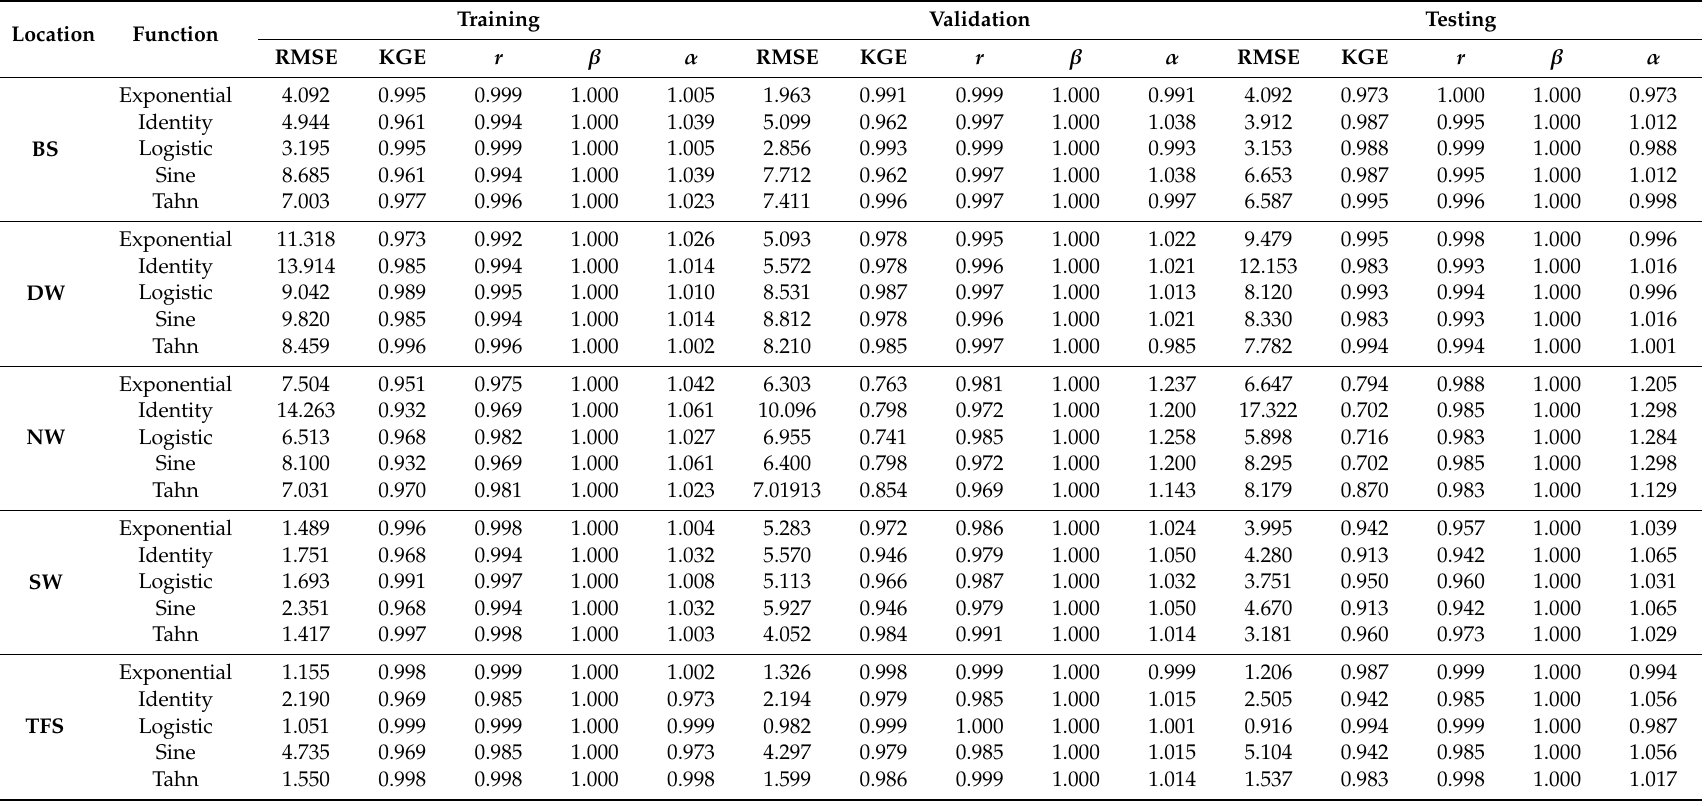
Table 1. Performance of the di ff erent activation